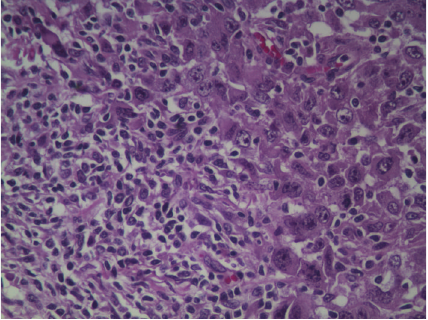
Figure 7: Left breast tissue (high power): poorly differentiated malignant cells, prominent nucleoli.